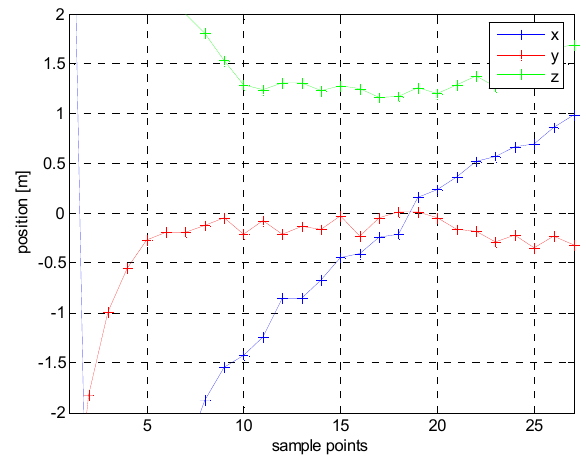
Figure 4. Calculated trajectory after the first round of LMA.